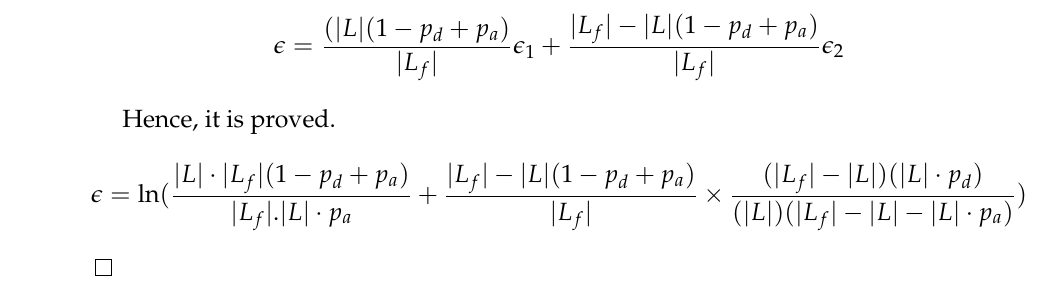
Table 2. Links and non-links in G and G p . Links in G Non-Links in G Sum Links in G p | L | ( 1 − p d ) Non-Links in G